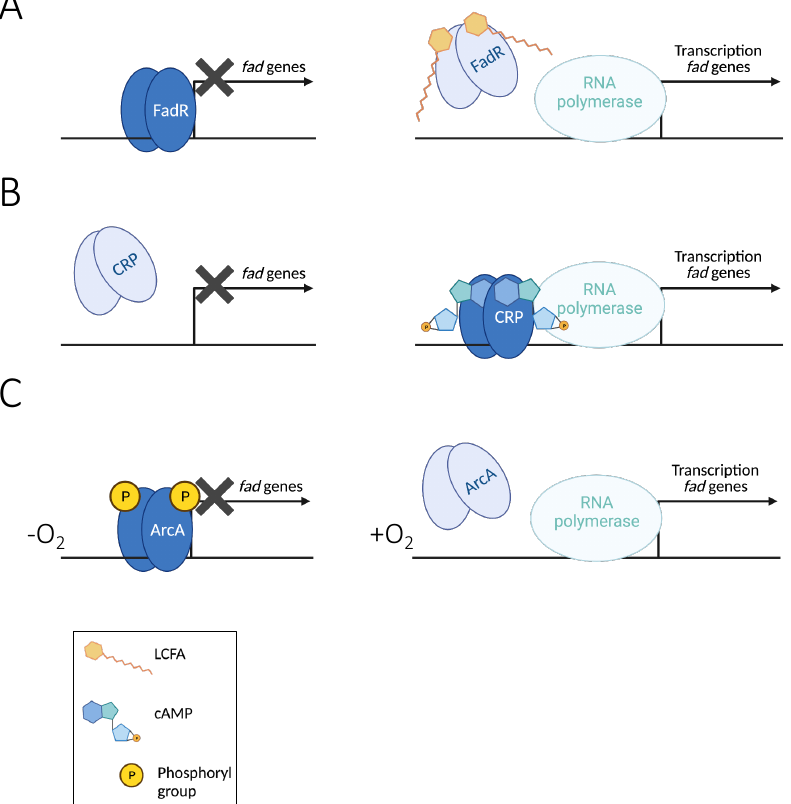
Figure 10. Control of fad gene expression by FadR, CRP, and ArcA. ( A ) FadR. A dimer of FadR binds the fad promoters. It prevents the RNAP binding and inhibits the transcription, as shown by the black cross ( left ). Binding of long-chain acyl-CoA results in conformational modification of FadR, which leaves the DNA, and as a consequence, the RNAP is recruited and transcription starts ( right ). ( B ) CRP: catabolite repression in the presence of glucose prevents fad gene expression ( left ). In the absence of glucose, the cAMP levels increase and the cAMP/CRP dimer binds the DNA and recruits the RNAP, so the transcription starts ( right ). ( C ) ArcAB two-component system: the absence of oxygen is sensed by ArcB, which auto-phosphorylates and transfers the phosphoryl group to ArcA. ArcA-P binds to DNA, preventing the RNAP recruitment ( left ). In the presence of oxygen, ArcA cannot bind DNA and the fad genes are transcribed ( right ). A legend with the cofactors of the different regulators is shown in the panel on the bottom.